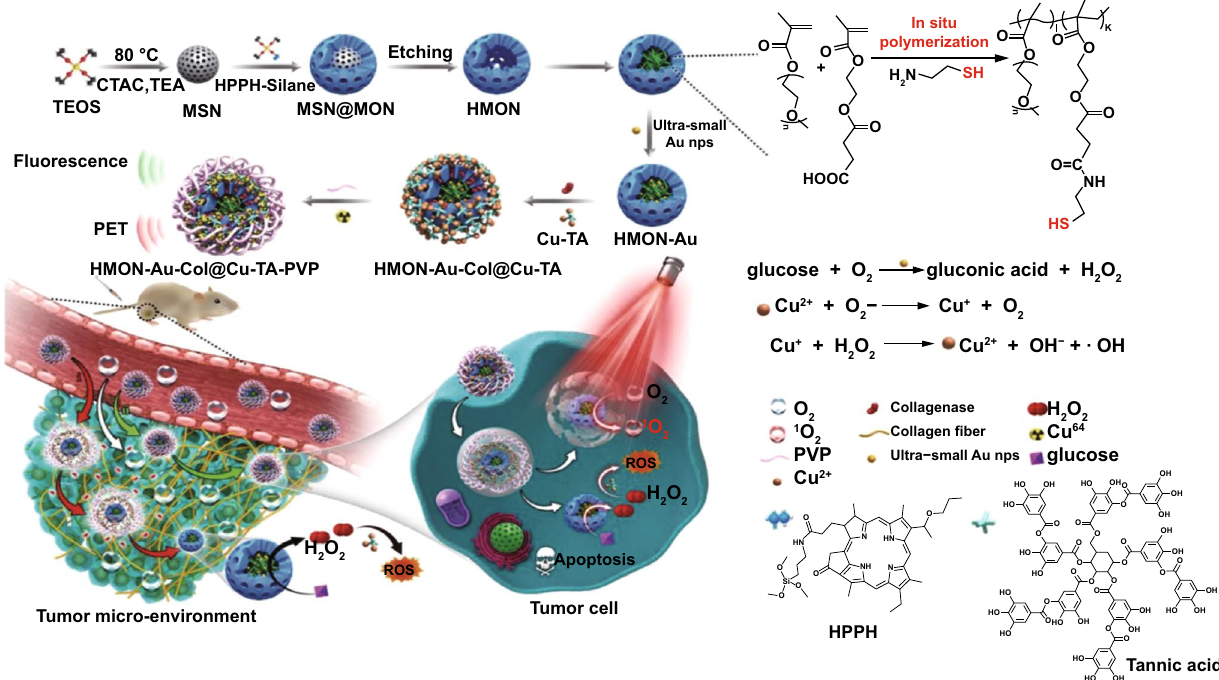
Fig. 5 Schematic showing the fabrication process of HMONs-Au@Cu-TA and its application for synergistic PDT/CDT therapy. Reprinted from Ref. [44] with permission. Copyright © 2019 WILEY-VCH Verlag GmbH & Co. KGaA,